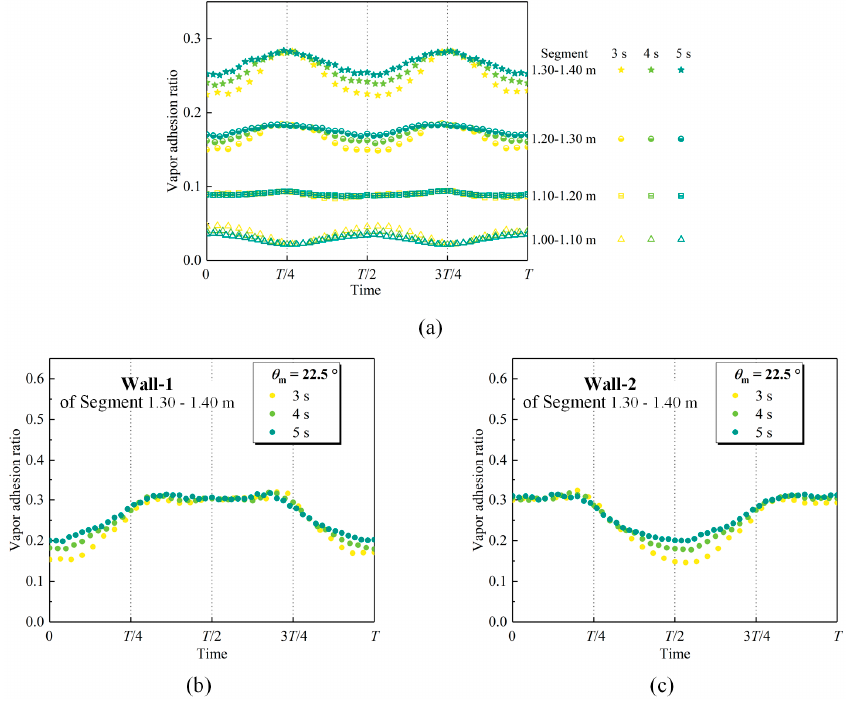
Figure 15. Effect of the period on the vapor adhesion ratio. ( a ) Segment; ( b ) Wall-1 of Segment 1.30–1.40 m; ( c ) Wall-2 of Segment 1.30–1.40 m.